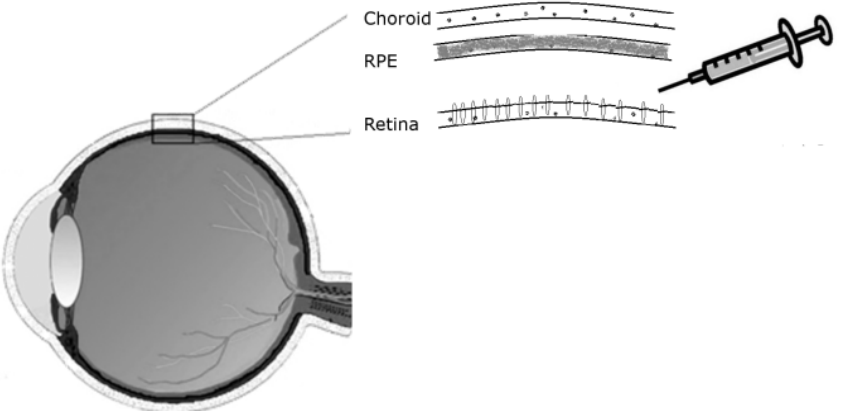
Figure 1. Subretinal injection route as used for delivery of therapeutic genes to the